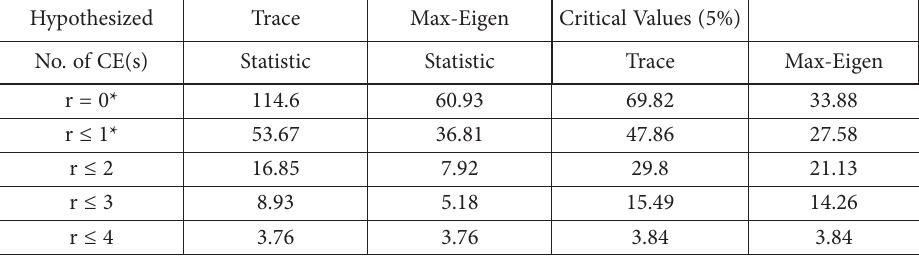
Table 4. Johansen-Juselius Cointegration test results with (lHOUSEHOLDS) (source: authors’ calculation) Hypothesized Trace Max-Eigen Critical Values (5%) No. of CE(s) Statistic Statistic Trace Max-Eigen r = 0* 114.6